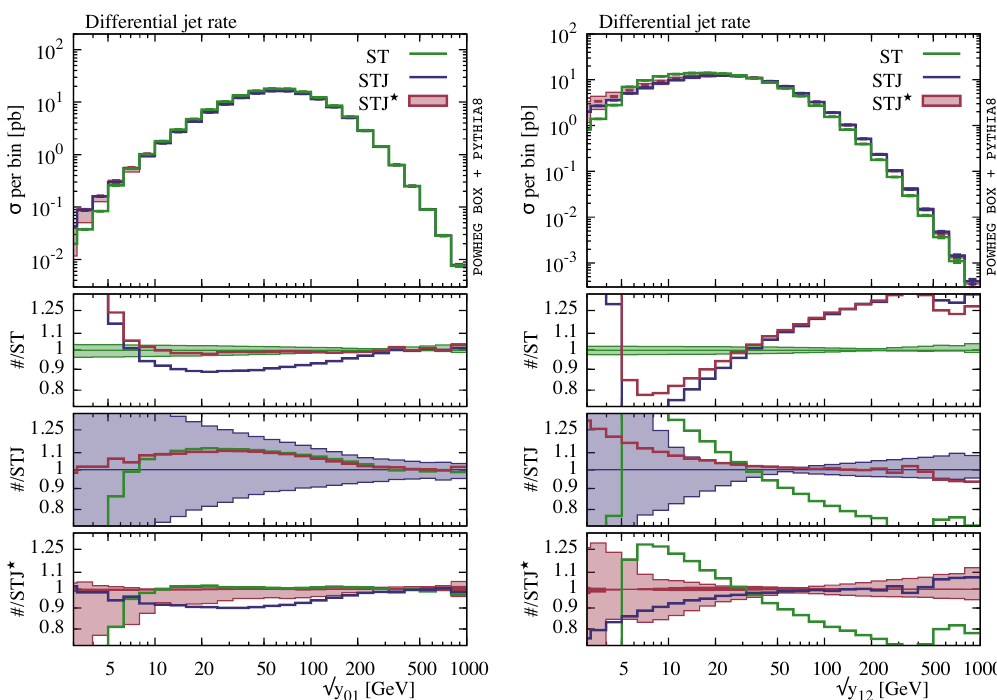
Figure 4 . Di(cid:11)erential jet rates in the exclusive k t clustering algorithm [80], with jet radius param- eter R = 1. The left-hand plot presents predictions for the 0 ! 1 jet rate, the value of the distance measure in that algorithm at which a 1-jet event would become resolved as a 0-jet one. The right-hand plot shows the 1 ! 2 jet rate, (cid:12)gures 2 and 3, all predictions include the e(cid:11)ects of parton showering provided by Pythia8 , and follow the same colour